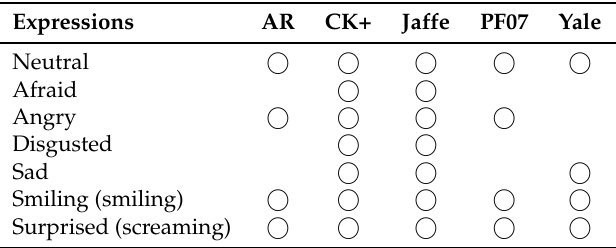
Table 3. Facial expressions in each database in the auxiliary set.